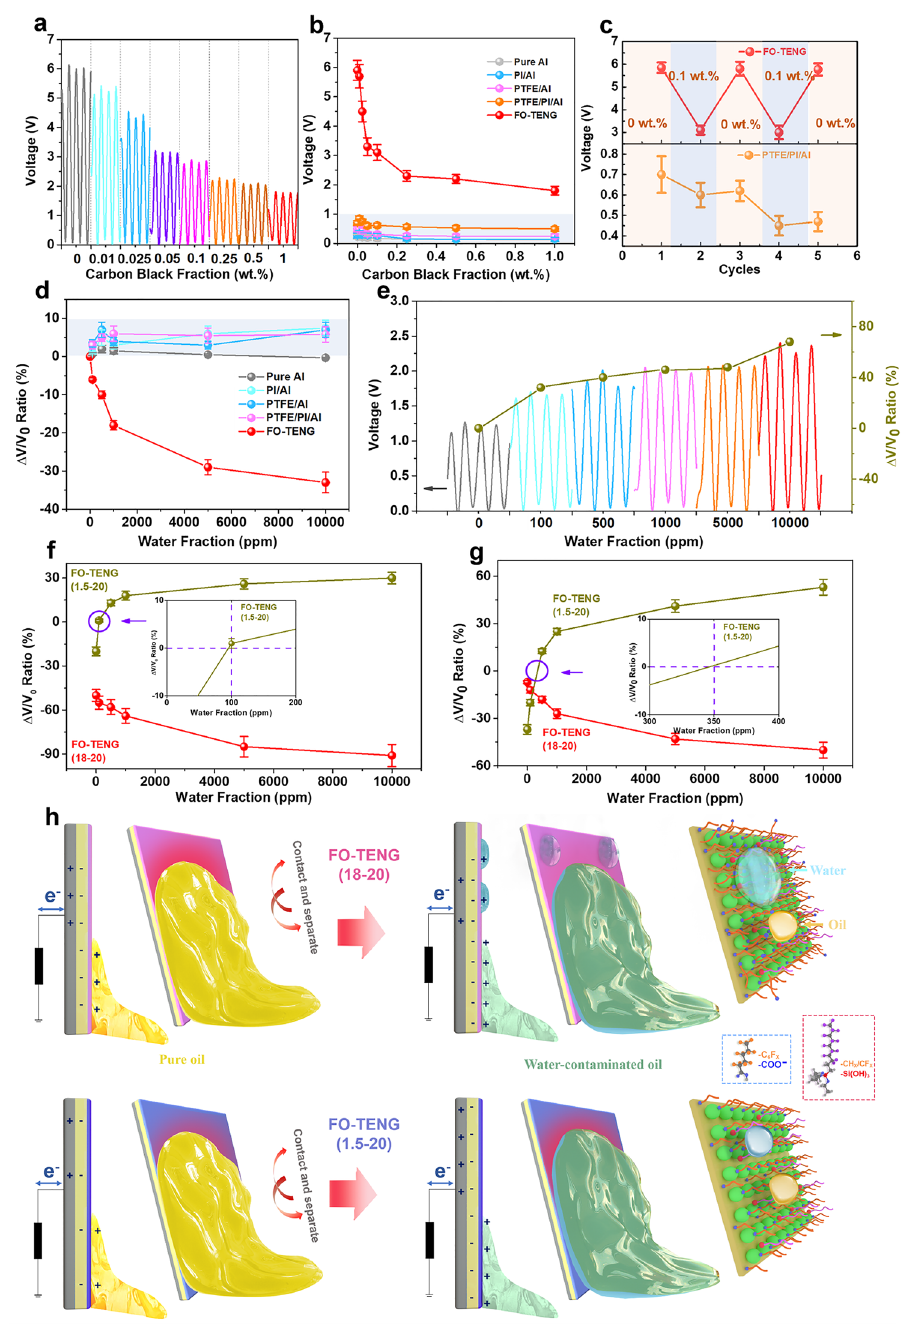
Fig. 4 Online and smart monitoring based on O-TENG. a, b The voltage output of the carbon black-ladened paraffin oil. c Reversible self- cleanability of the FO-TENG (18–20) compared with the O-TENG (PTFE/PI/Al). d Comparison of normalized voltage output of O-TENGs contacting the water-ladened paraffin oil. e The voltage output of the FO-TENG (1.5–20) contacting the water-ladened oil. f The voltage out- puts of FO-TENGs identifying the water fraction in a contaminant-ladened paraffin oil (carbon black: 0.1 wt%). g The voltage outputs of FO- TENGs identifying the water fraction in a commercial contaminant-ladened lubricating oil. h Schematic of the FO-TENG systems for identify- ing intruded water in oils by surface wetting property